Question: What visual encoding does this figure use to show its data?
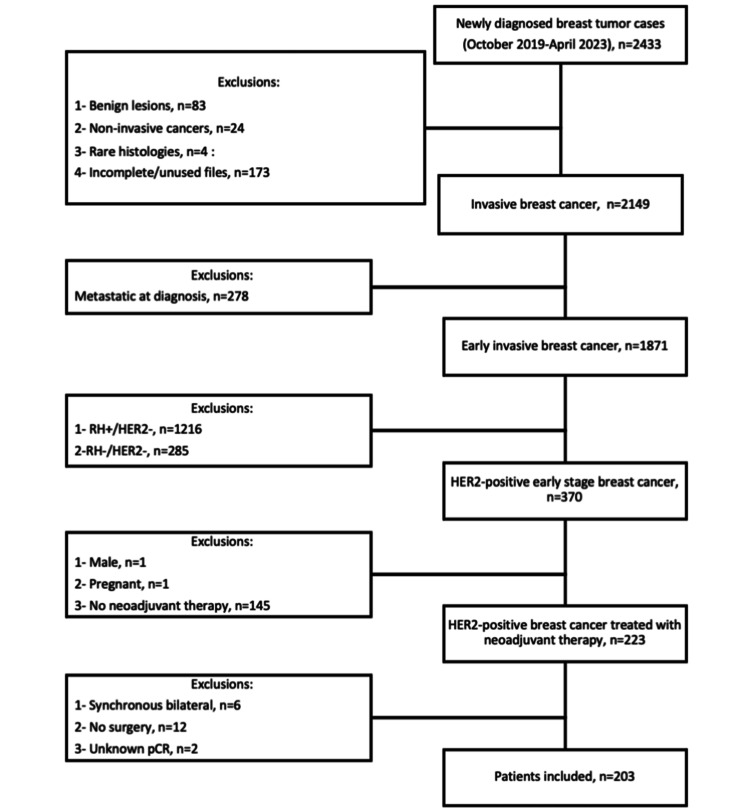
Answer: line